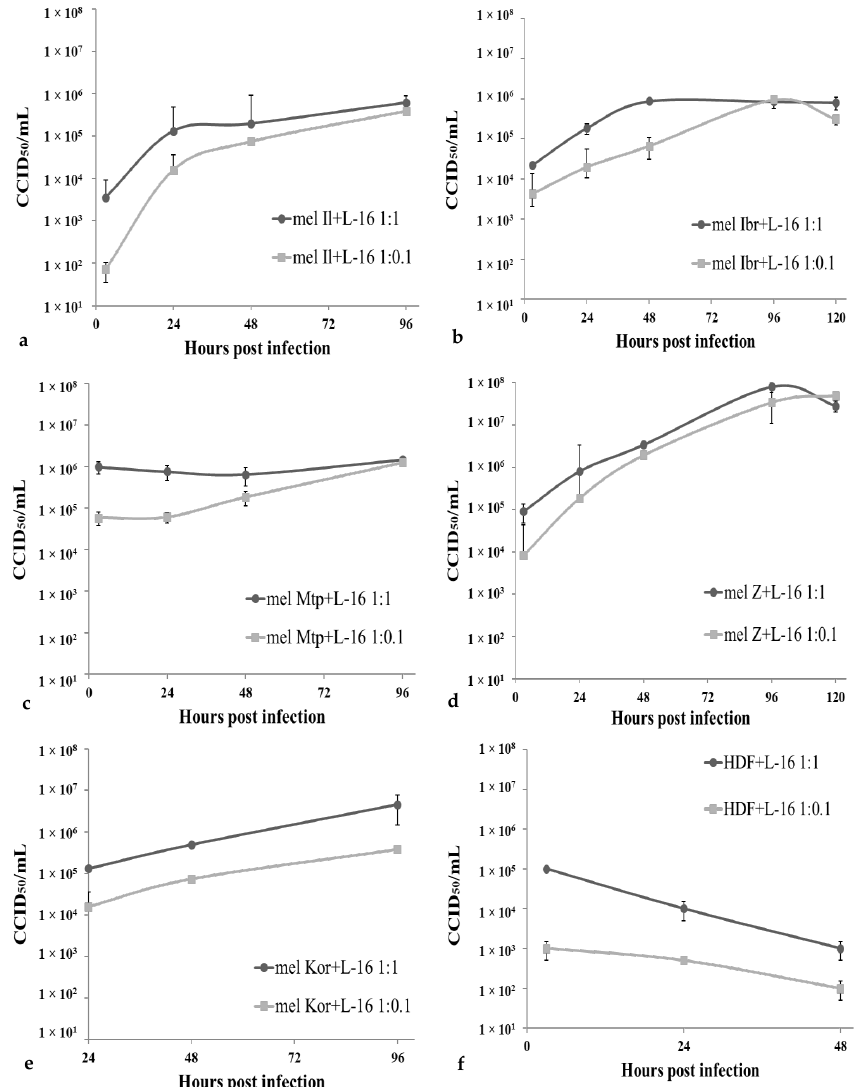
Figure 4. Production of MV strain L-16 in infected melanoma cells and fibroblasts. Melanoma cells, mel Il ( a ), mel Ibr ( b ), mel Mtp ( c ), mel Z ( d ), mel Kor ( e ), or HDF ( f ) cells were infected with MV at a MOI of 1.0